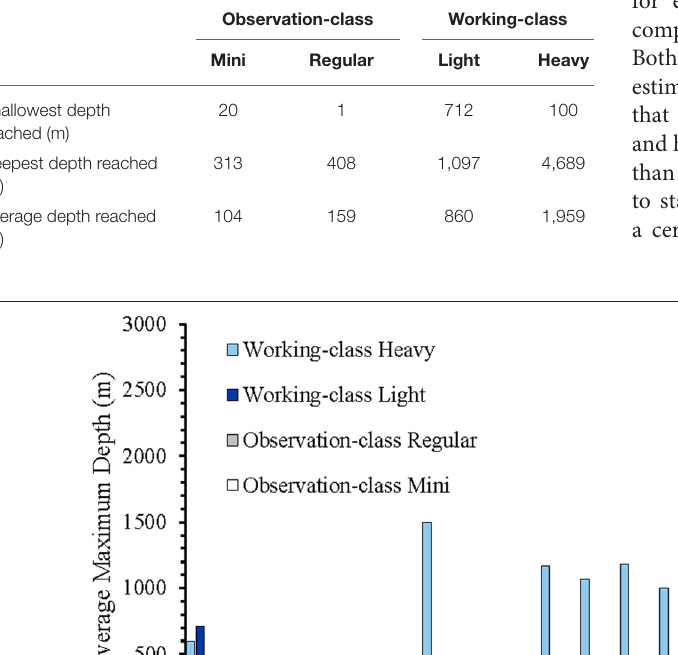
Frontiers in Marine Science |